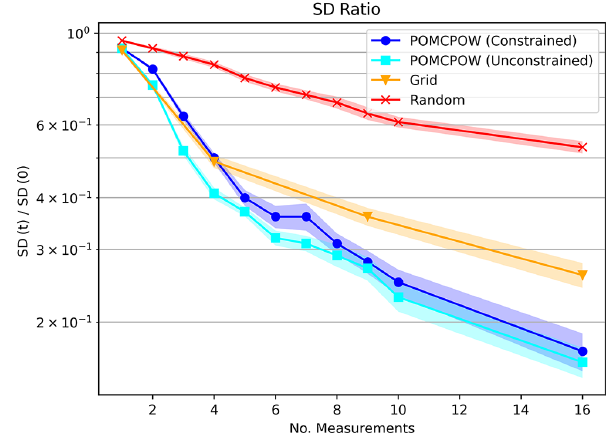
Figure 18. Measurement distance to center, POMCPOW without action constraints, single body with fixed location. The plot shows the average distance between the measurement location and the mineralization center for the measurements at each time step. 1 stan- dard error bars are also presented.